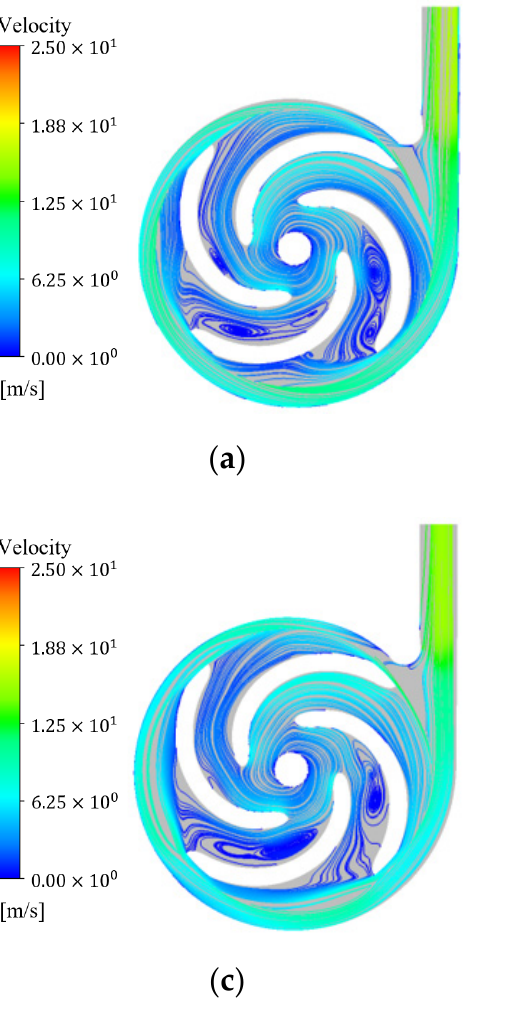
Figure 12. Velocity streamline distributions of impeller-volute with different solid volume fractions under 1.0 Q BEP : ( a ) C V = 0%; ( b ) C V = 5%; ( c ) C V = 10%; ( d ) C V = 15%.